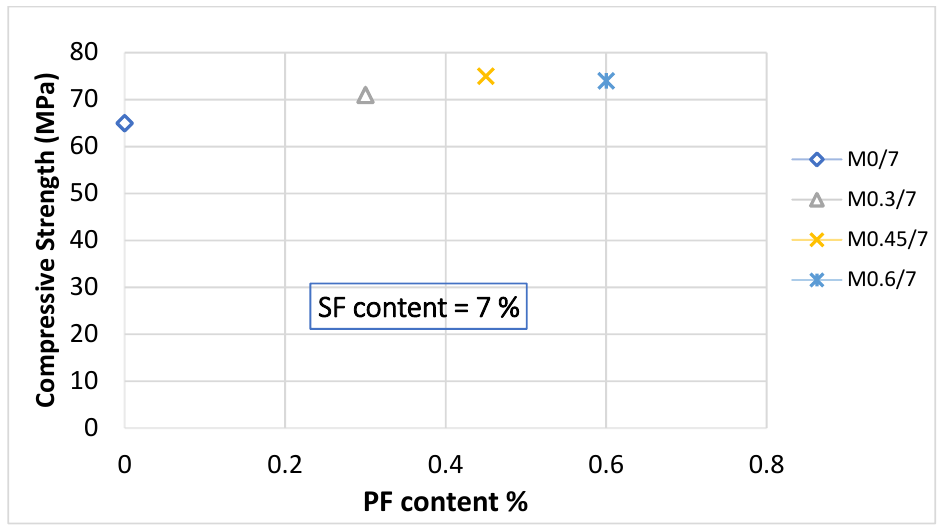
Figure 10. Effect of polypropylene fiber content on compressive strength under ambient conditions.